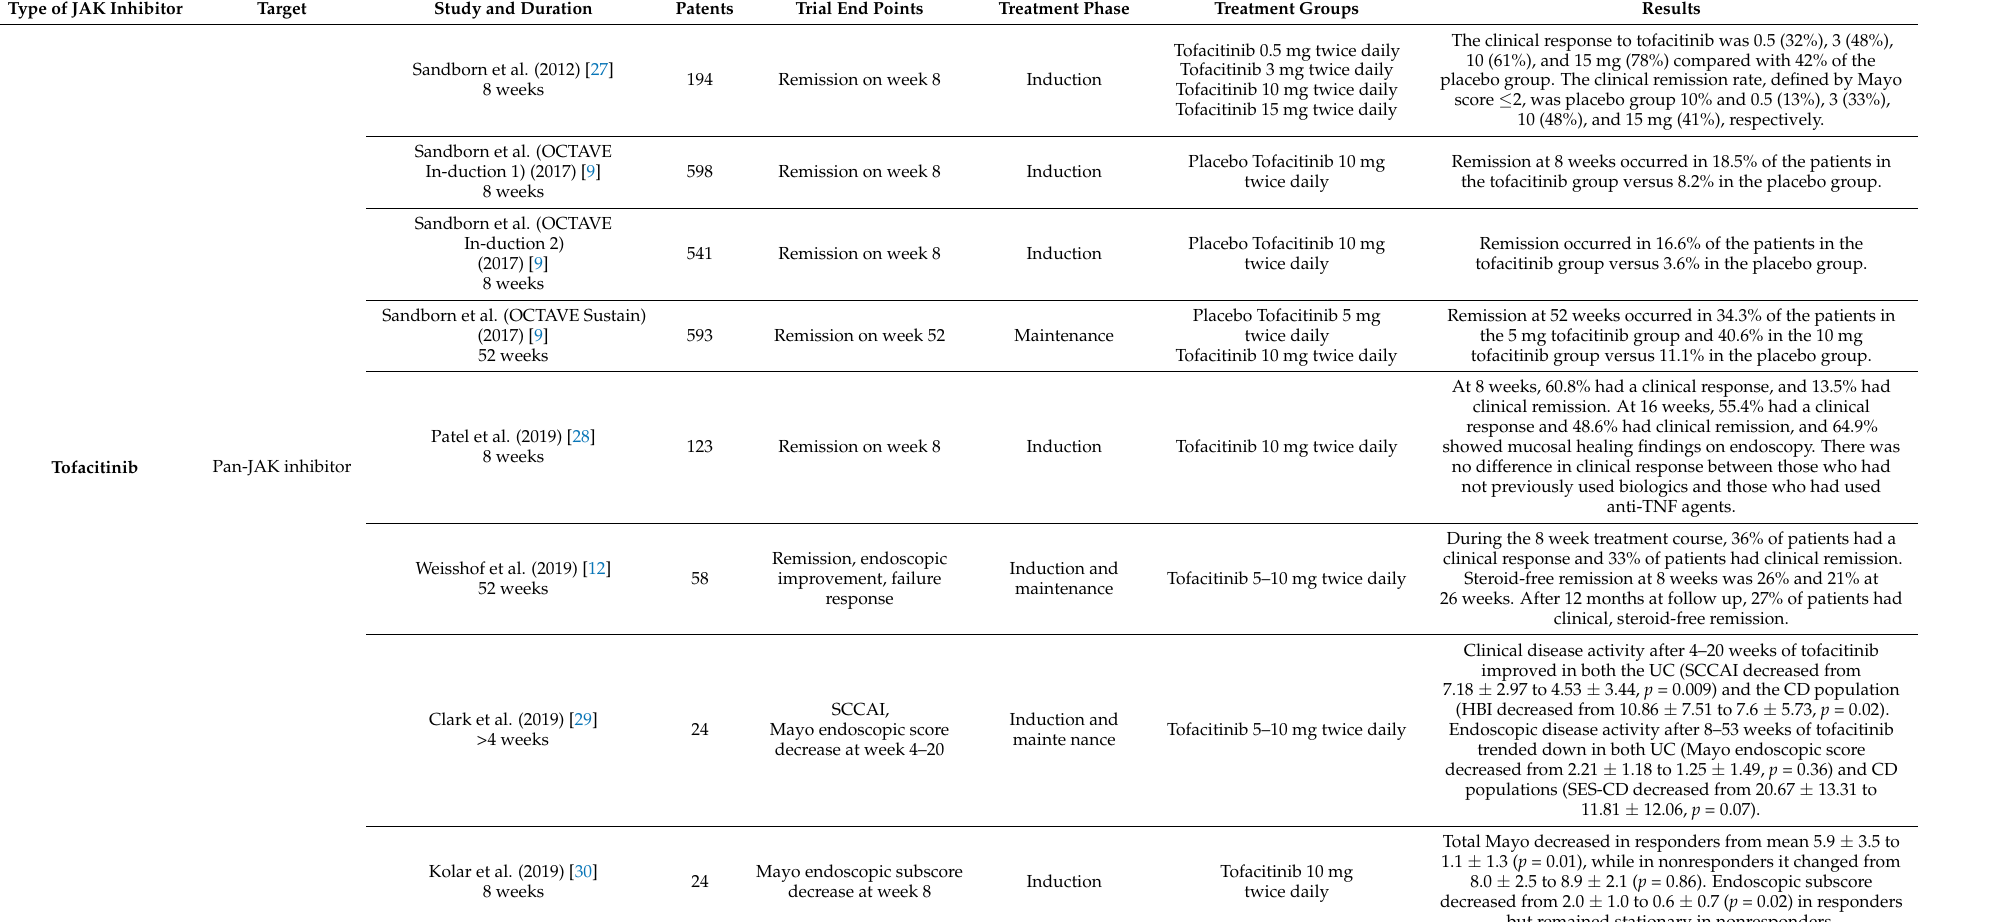
Table 1. JAK Inhibitors for UC